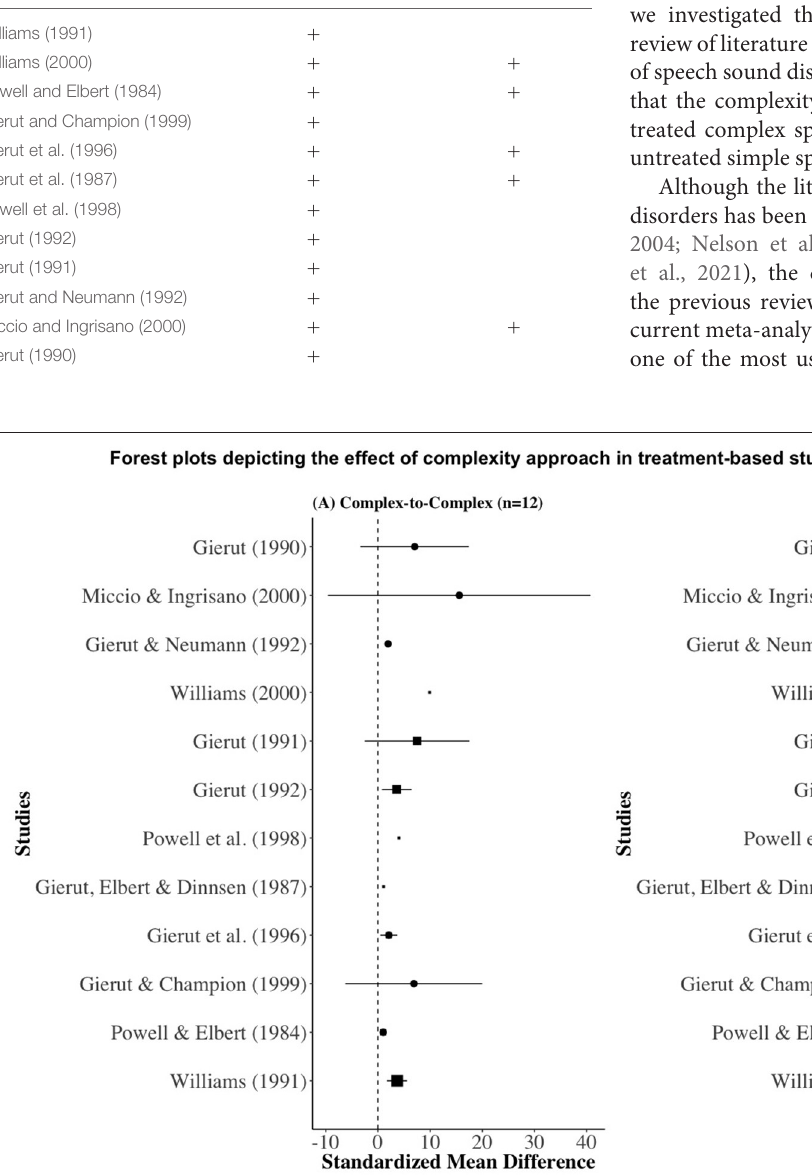
Frontiers in Psychology |